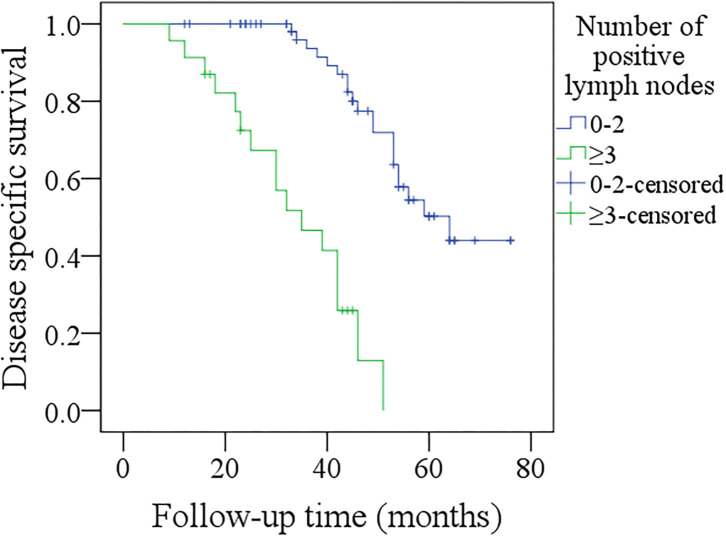
Comparison of disease-free survival among p16 positivity patients with different numbers of positive lymph nodes (p < 0.001).